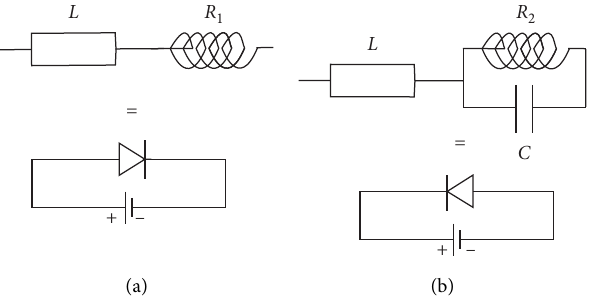
Figure 10: Equivalent circuit of the PIN diodes: (a) forward bias; (b) reverse bias.